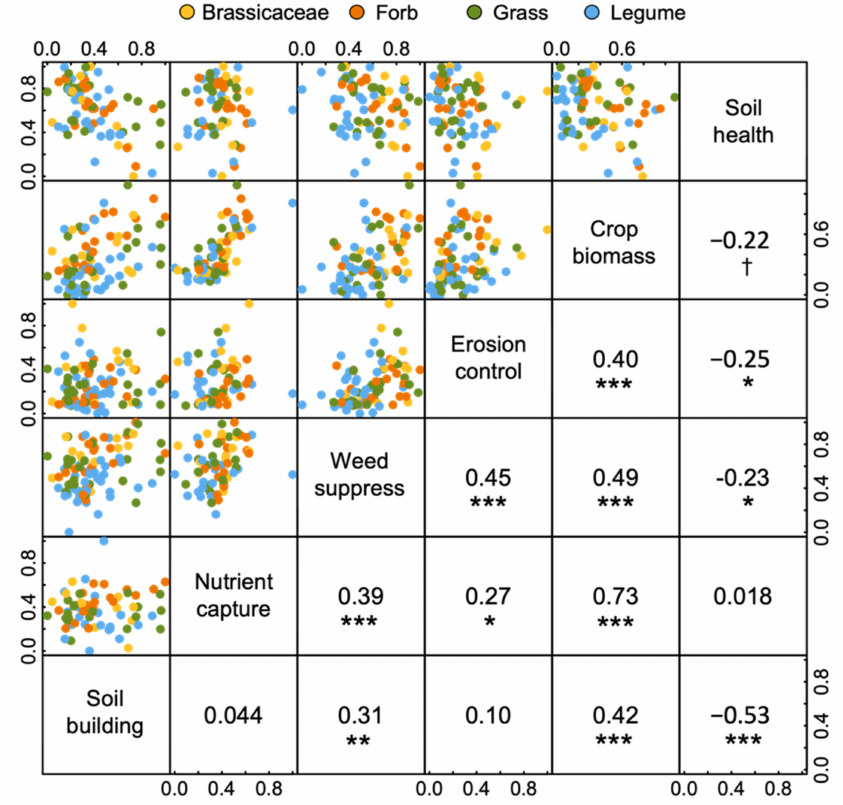
Figure 7. Correlations among agroecosystem services. The upper triangle above the shaded cells are the pair-wise scatter plots and below are the Spearman correlation values with asterisks indi- cating † p < 0.1, * p < 0.05, ** p < 0.01, *** p < 0.001. An ordination showing the association among agroecosystem services and crops they map onto is shown in Figure